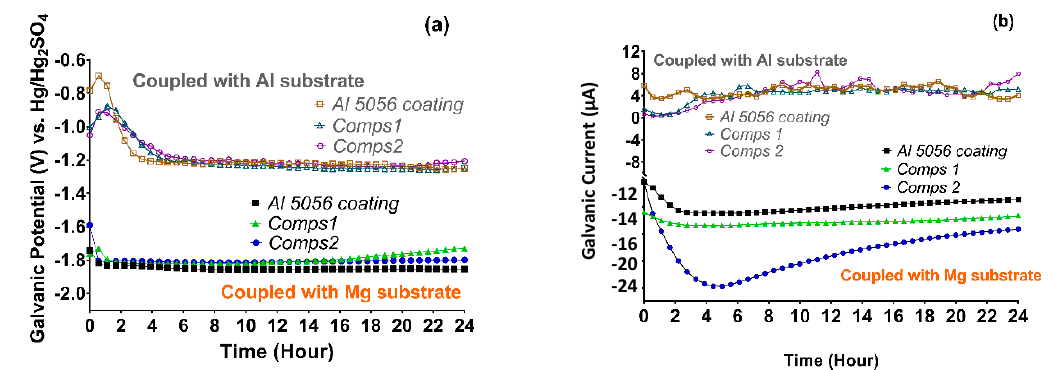
Figure 5. ( a ) Galvanic potentials (E gal ) and ( b ) galvanic currents (I gal ) of the coatings coupled to the Mg substrate and Al substrate in 0.1 M Na 2 SO 4 solution. Table 1. Electrochemical data of the cold-sprayed SiC p / Al 5056 composite coatings and Mg substrate (all potentials are referenced to the Hg / Hg 2 SO 4